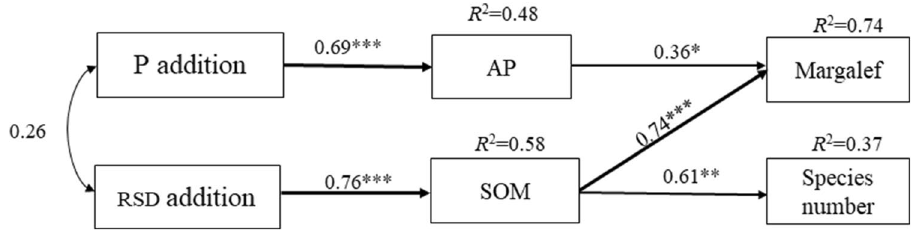
Figure 6. Structural equation model. Black arrows indicate a positive relationship; the number on the arrow is the normalized path coefficient. The R 2 value represents the ratio of variation to the other variables explained, * P < 0.05, ** P < 0.01, *** P < 0.001. SOM soil organic matter, AP available